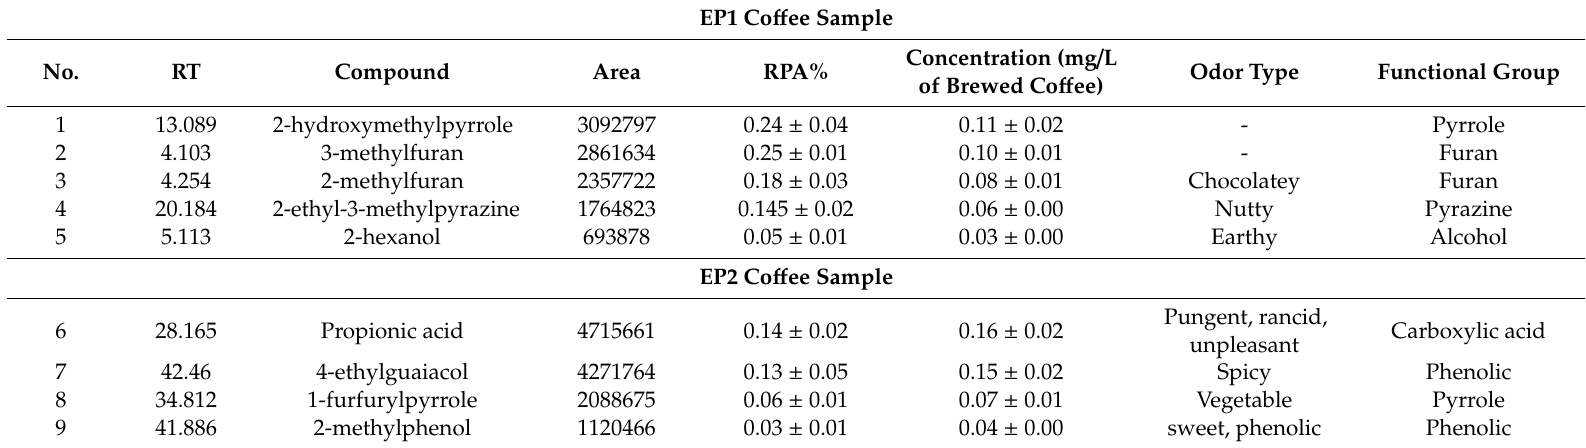
Table 3. Volatile compounds found only in EP1 and EP2 brewed co ff ee